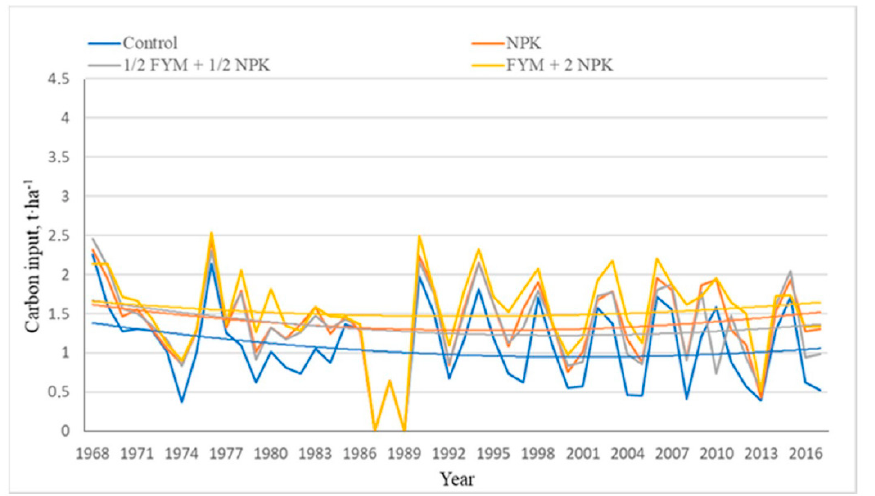
Figure 1. The annual carbon (C) input in the long-term field experiment with plant residues. On the axis of abscissas—the year of input, on the axis of ordinate—the input according to crop-specific biomass allocation coefficients of organic C with stubble and belowground biomass. Smoothing was done with second-degree polynomials.